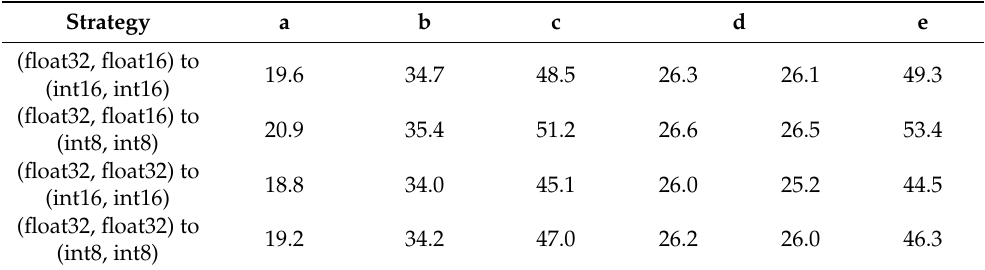
Table 7. Effects of different quantization degrees on the method’s FPS. a, b, c, d, and e in the table, respectively, represent the five video processing methods in Figure 5, that is, the strategy corresponding to the five subfigures, where the two methods in strategy d are run in parallel.